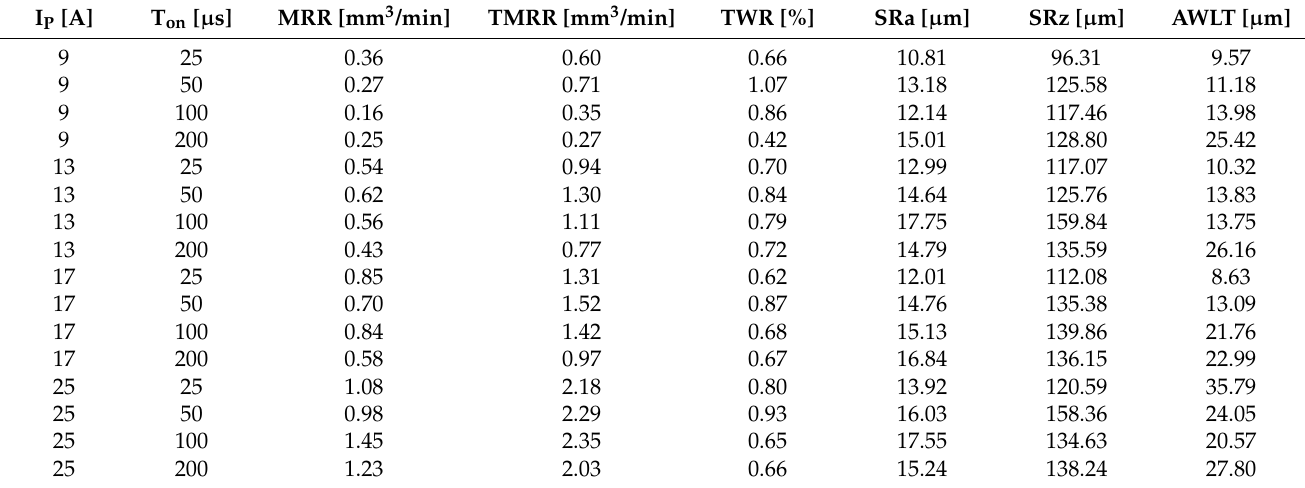
Table 4. Experimental